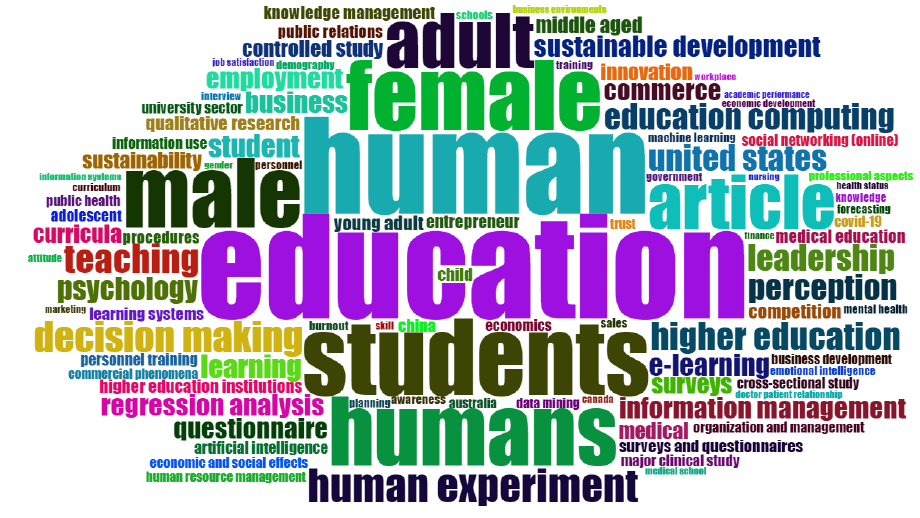
Figure 7. A Cloud of the 100 Most Used Keywords by Research Topic